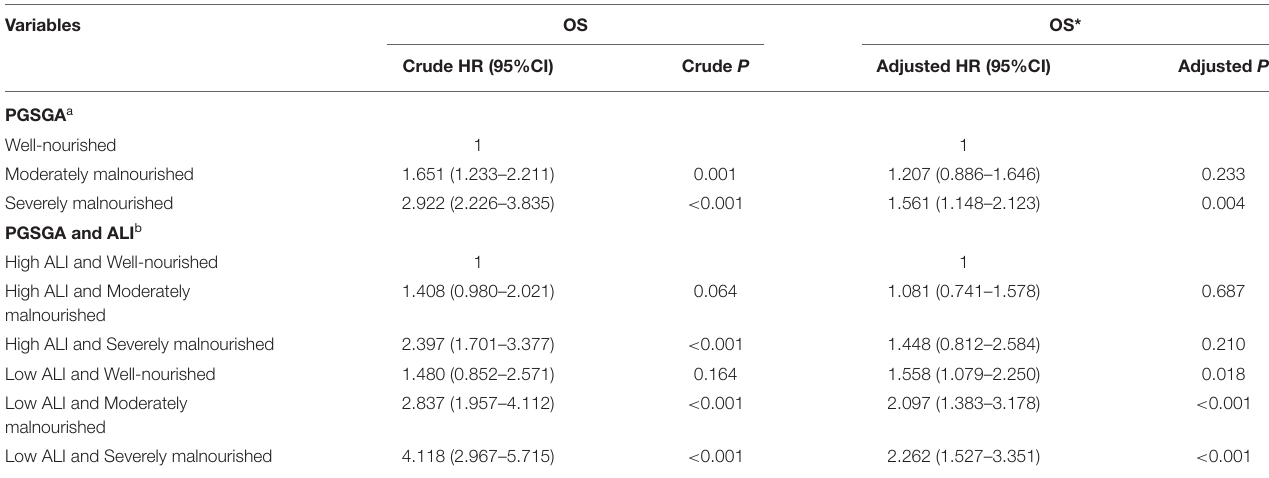
TABLE 3 | Combined effect survival